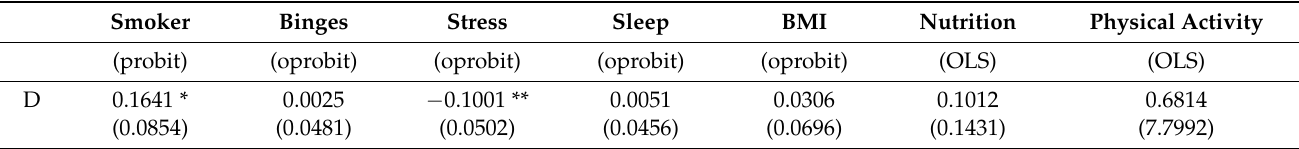
Table 2. D with personality and ability measures (estimated coefficients from probit, ordered probit, and ordinary least squares